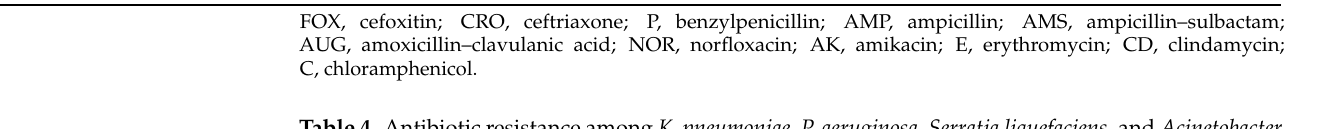
Table 4. Antibiotic resistance among K. pneumoniae , P. aeruginosa , Serratia liquefaciens , and Acinetobacter spp. strains isolated from healthy